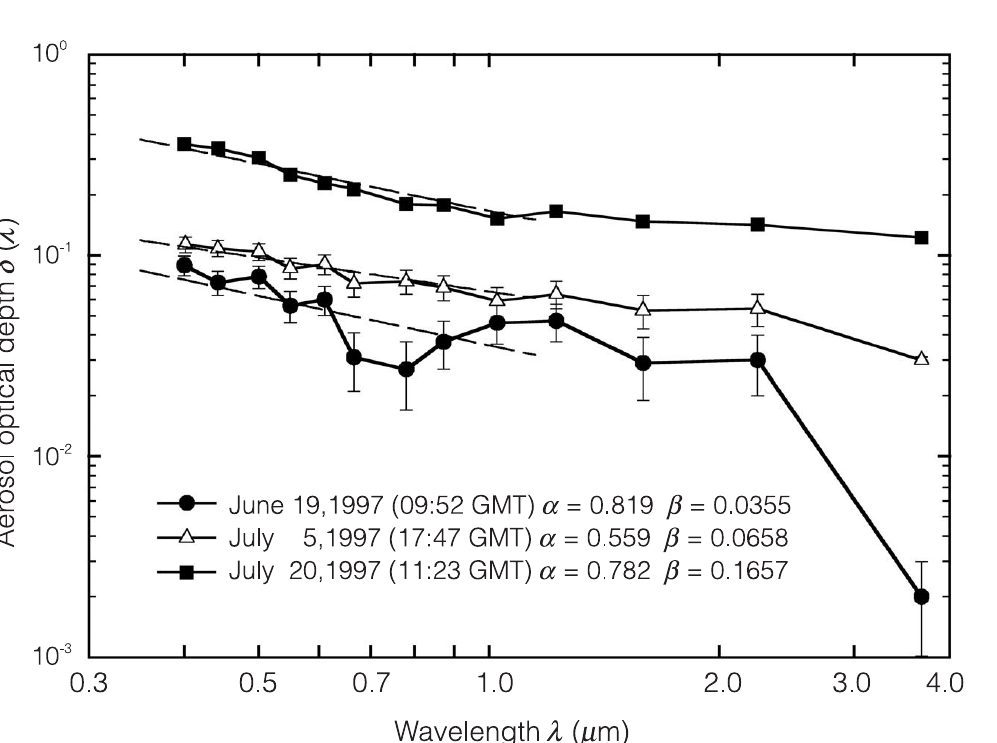
Fig. 1. Spectral series of aerosol optical depth d ( l ) determined from the IR-RAD sun-photometer measurements carried out on June 19, 1997, at 09:52 GMT (circles), July 5, 1997, at 17:47 GMT (triangles), and July 20, 1997, at 11:23 GMT (squares). The corresponding Ångström (1964) best-fi t lines determined in the 0.401-1.025 m m spectral range are also drawn (dashed lines), together with the corresponding best-fi t values of atmospheric tur- bidity parameters a and b